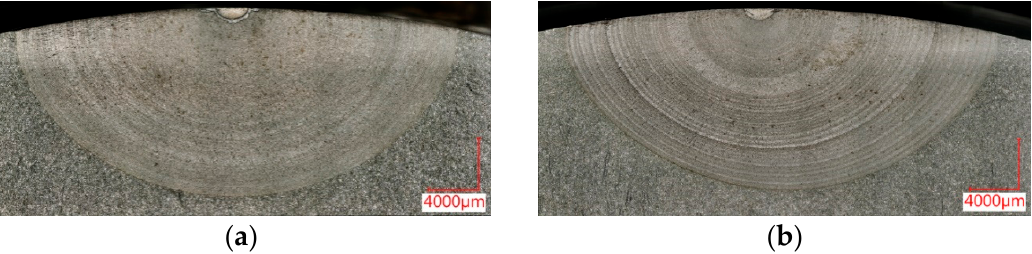
Figure 1. Two typical fractographies of semi elliptical cracks in rotating bending loaded 1:1 railway axle specimens: ( a ) Moderate visibility of beach marks; ( b ) Improved visibility of beach marks. Furthermore, in some cases deviations from typical reported fracture surfaces are noticed.